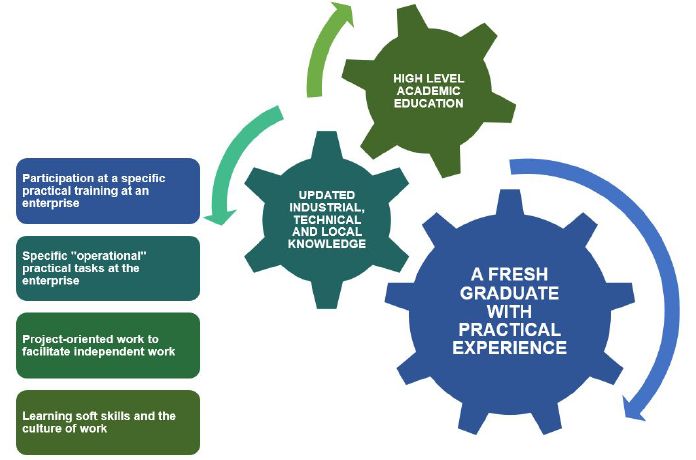
Fig. 2. The elements of dual